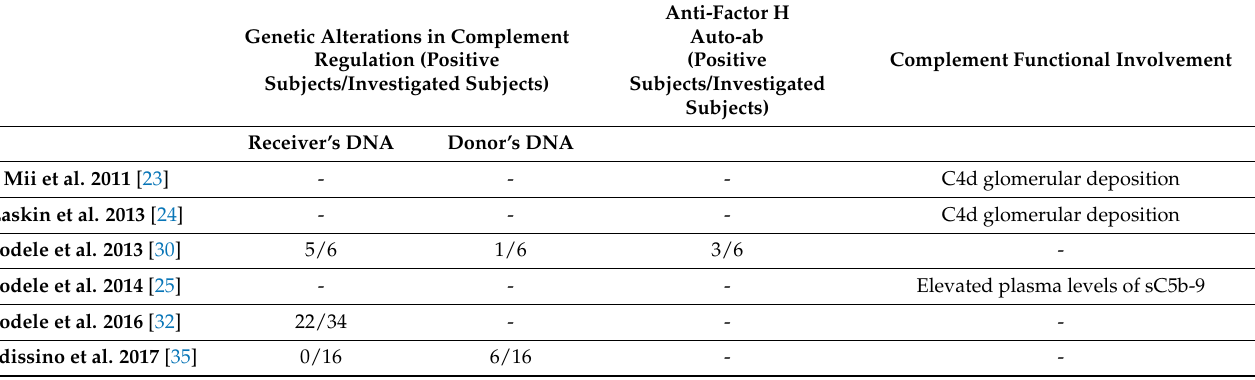
Table 2. Evidence of genetic and functional involvement of complement in